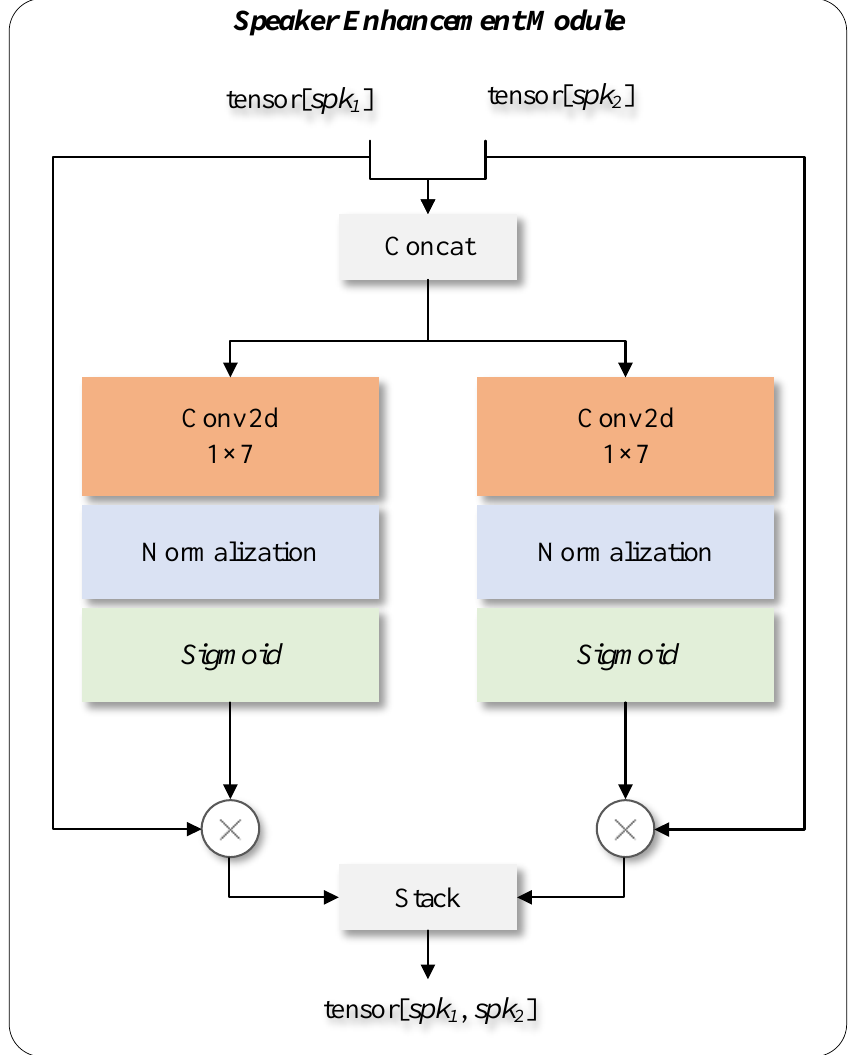
Figure 5. The internal structure of the speaker enhancement module, as the post-processing module of the model, uses the temporal correlation characteristics of the same speaker ’ s speech to improve the separation performance of the model.